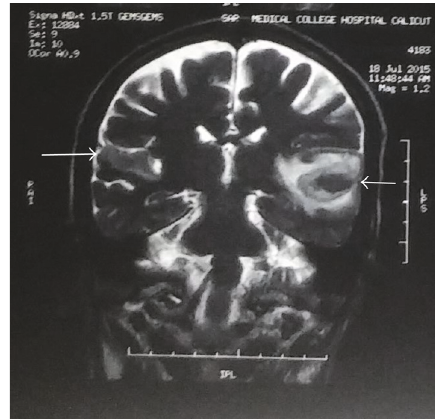
Figure 2: MRI brain showing infarcts in bilateral Heschl